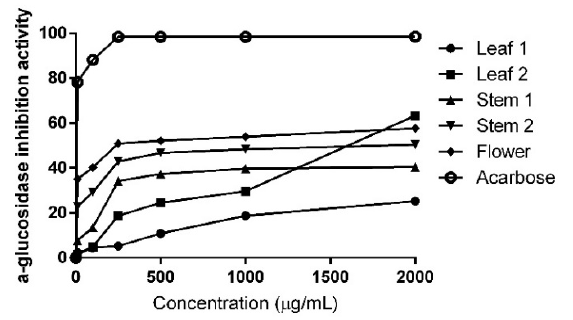
Figure 4: α -glucosidase enzyme inhibition activity of acarbose and M. sativa L. extracts at different growing period.